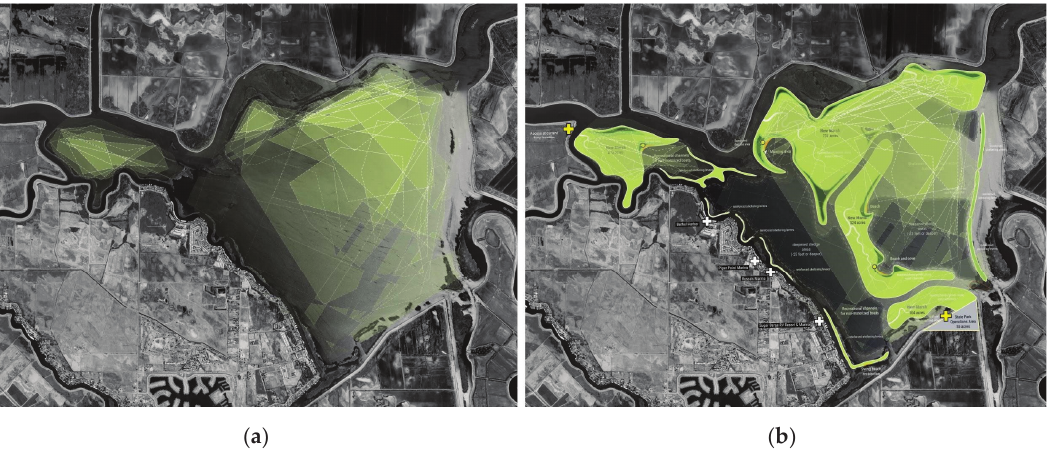
Figure 12. Where are the areas in Franks Tract that most need improvement? What improvements can be made? Results identify many types of desired improvement throughout Franks Tract, with some comments in opposition. Common improvements include addressing boating hazards (which includes removal of weeds, snags, submerged levee remnants and deepening of shallow